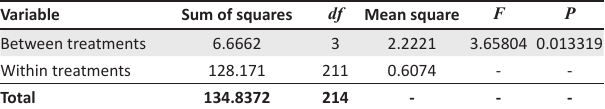
TABLE 3: Analysis of variance results on making predictions in isiXhosa.